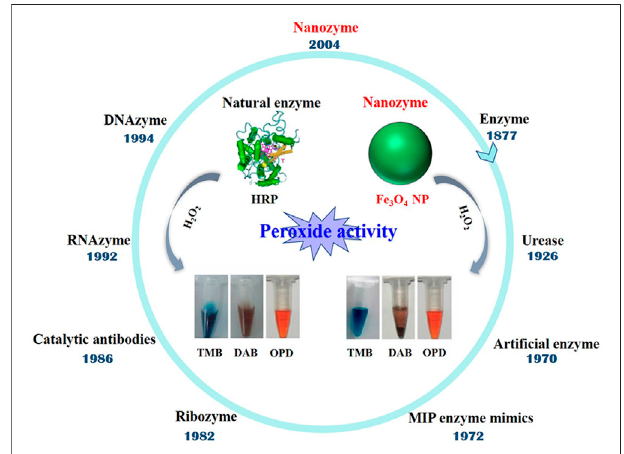
FIGURE2| Thehistoryofnanozymeinenzymemimicsandtheevidence of Fe 3 O 4 NP behaving peroxide activity (inset).